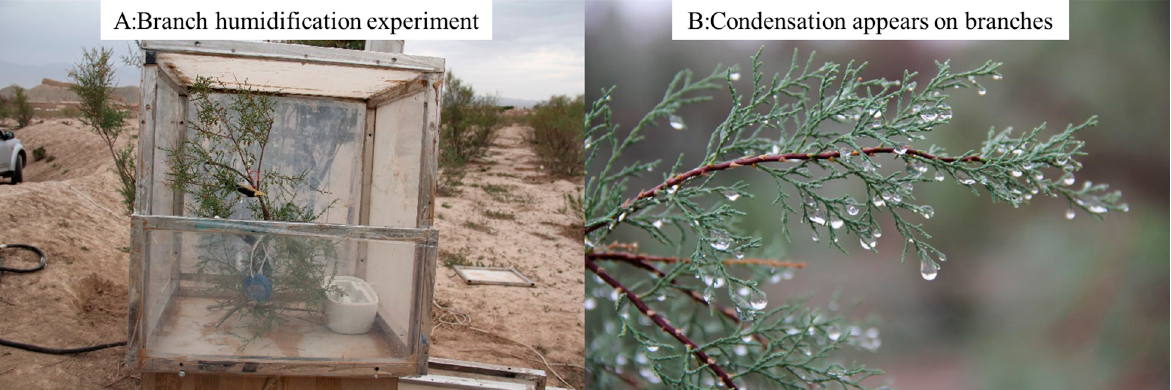
Figure 4. ( A ) Control room for humidifying parts of the Tamarisk branches, collection of wetted leaves, and counting of the difference in water content between water-absorbing and non-water- absorbing leaves. ( B ) Condensation on tamarisk branches observed under high RH